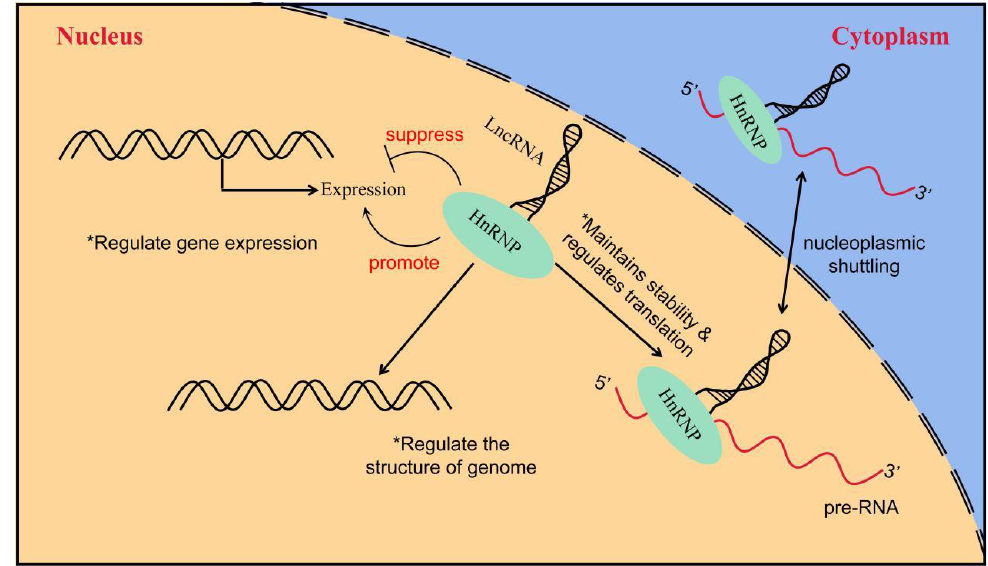
Figure 3. The way in which LncRNA interacts with hnRNP to regulate gene expression. LncRNA interacts with hnRNP to induce or inhibit gene expression; LncRNA regulates genome structure through interaction with hnRNP and indirectly affects gene expression; the interaction between lncRNA and hnRNP controls the stability and translation of mRNA.